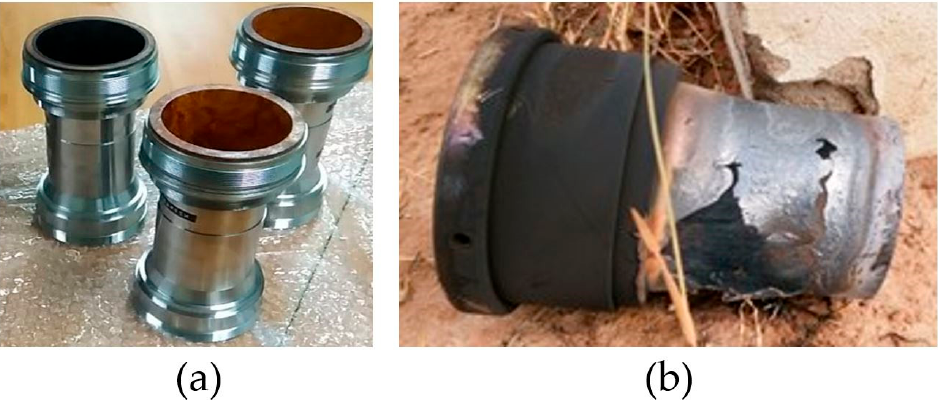
Figure 1. Samples of the 122 mm supersonic rocket nozzle ( a ) before and ( b ) after the mission, exhibiting excessive ablation.